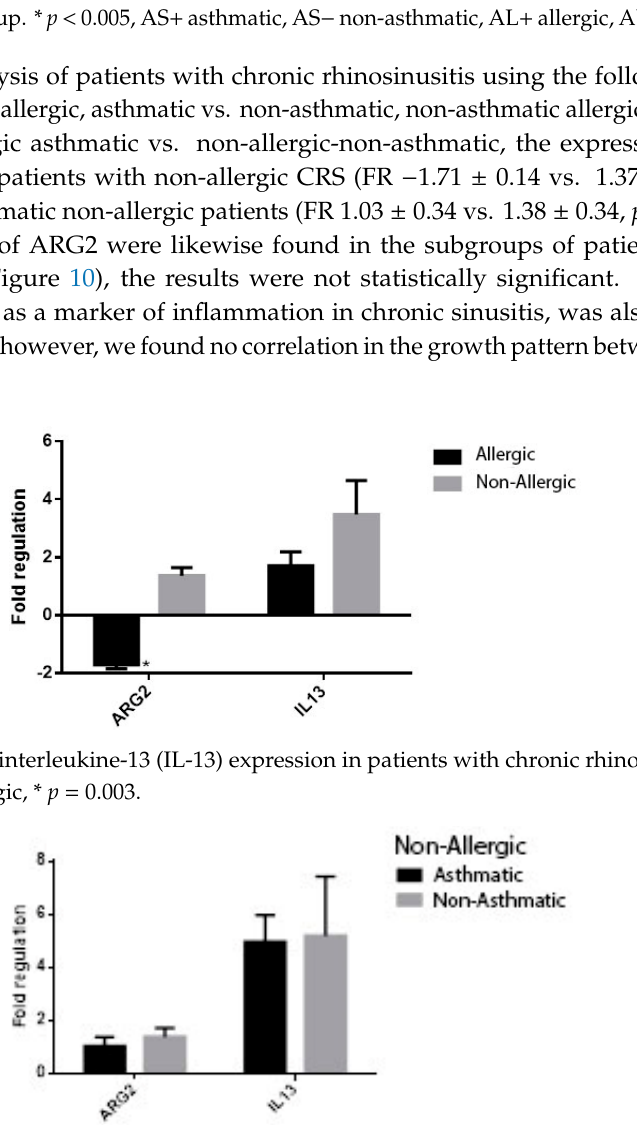
Figure 9. ARG2 and IL-13 expression in patients with CRS: asthmatic vs. non-asthmatic. p = 0.23. Figure 10. ARG2 and IL-13 expression in patients with CRS and no asthma: allergic vs. non-allergic. p = 0.27. 4. Discussion Nitric oxide is an important airway mediator, and its role in chronic rhinosinusitis represents a subject of high interest. It is produced mainly by the nasal and bronchial epithelial and inflammatory cells under the control of inducible NO synthase (iNOS or NOS2) [22]. NO is part of the first-line host defense mechanisms; its high concentration in the paranasal sinuses can reach up to 23.000 ppb [10], ensuring an antibacterial, antiviral, and antifungal effect. NO increases mucociliary clearance by upregulating ciliary motility; an association between low levels of NO and impaired mucociliary transport has been established [23,24]. Importantly, nitric oxide can display a pro- or anti- inflammatory effect conditioned by the type and phase of airway inflammation, its local concentration, and the individual response [25]. In the respiratory tract, nitric oxide has been shown to be involved in both T helper type 1 (Th1) and Th2 immunologic response [5,26,27]. Th1 lymphocytes secrete interleukin (IL)-2 and interferon-gamma (INF- γ ); they are associated with non- eosinophilic inflammatory diseases and intense phagocytic activity [28,29]. Th2 are closely involved